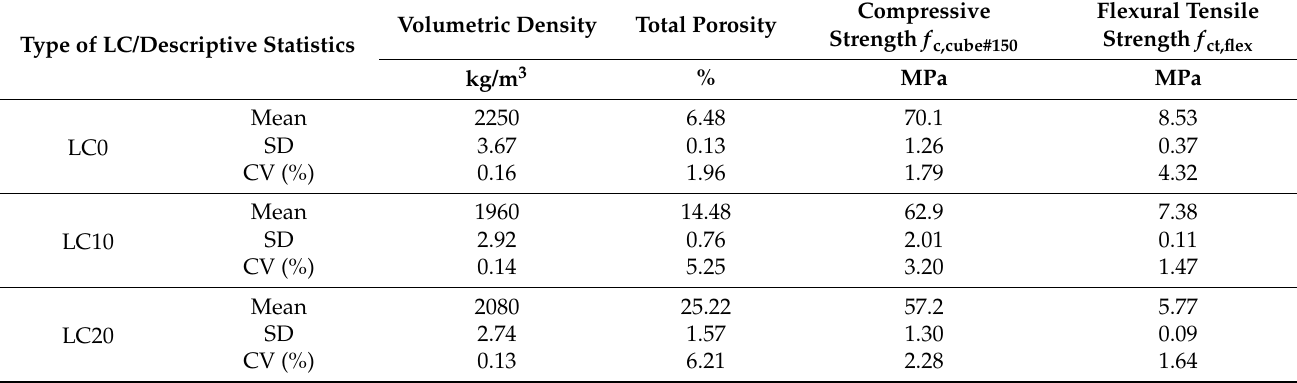
Table 6. Basic properties of the tested